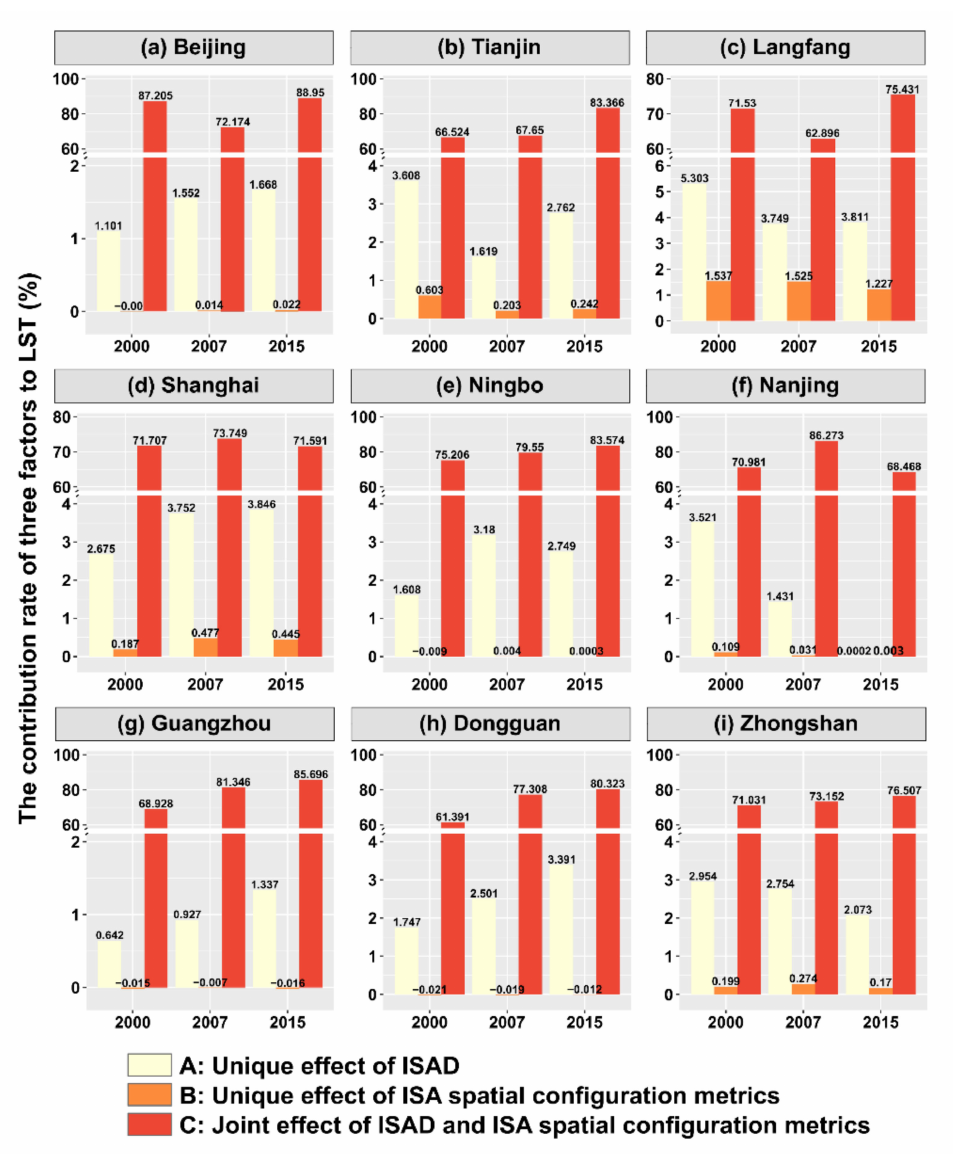
Figure 11. Unique effect of the ISAD and unique effect of the ISA landscape configuration metrics on the LST, and joint effect of the ISAD and the ISA landscape configuration metrics on the LST from 2000 to 2015 in different urban sizes and levels considered in this